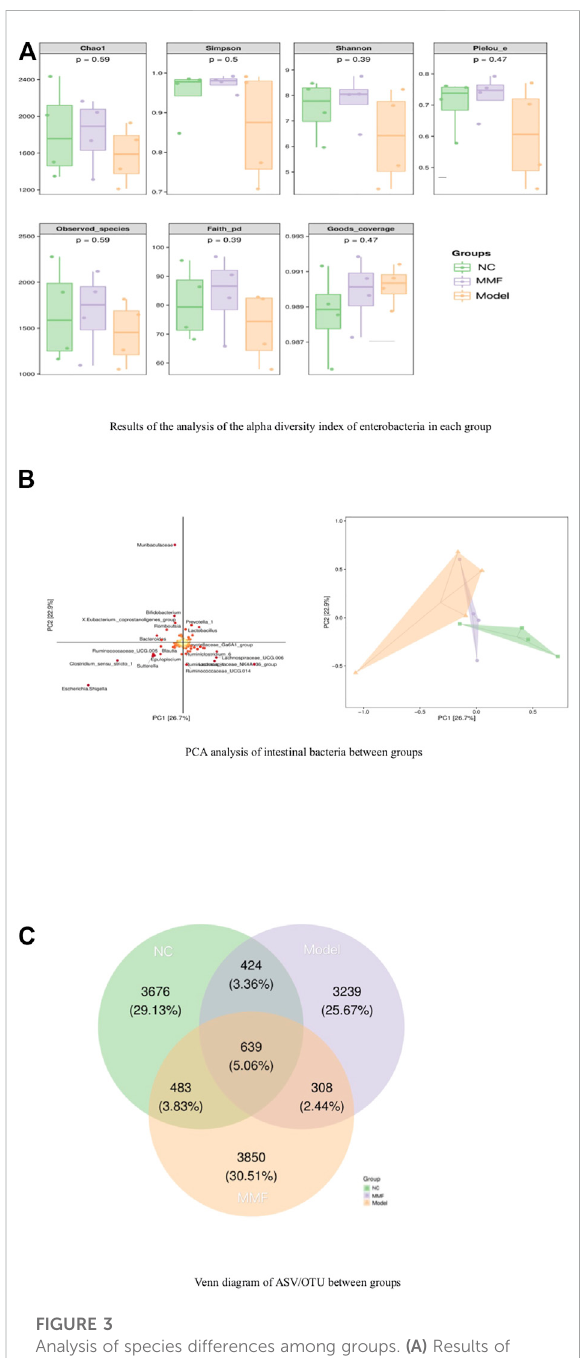
FIGURE 3 Analysis of species differences among groups. (A) Results of the analysis of the alpha diversity index of enterobacteria in each group. (B) PCA analysis of intestinal bacteria between groups. (C) Venn diagram of ASV/OTU between